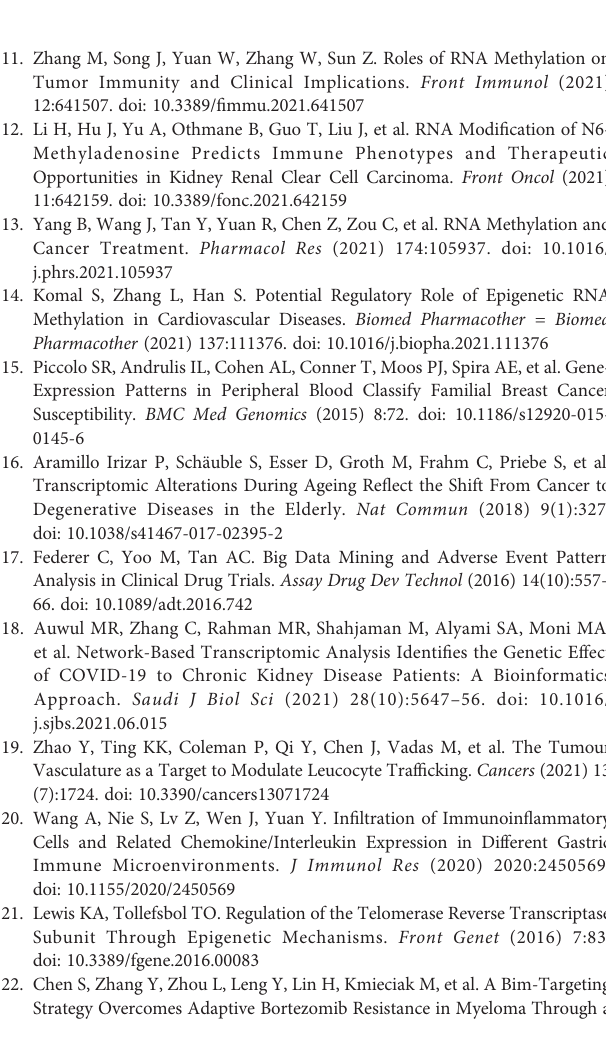
Supplementary Figure 1 | Calibration plots of the prognostic model in the derivation cohort. Supplementary Figure 2 | Calibration plots of the prognostic model in the validation cohort. Supplementary Figure 3 | A Nomogram predicting 1-, 3-, 5-year OS rate. Supplementary Figure 4 | ROC curves of the combined nomogram in the derivation cohort. Supplementary Figure 5 | ROC curves of the combined nomogram in the validation cohort. Supplementary Figure 6 | Analysis of GO and KEGG enrichment for DEGs. The size of bubbles represents the number of